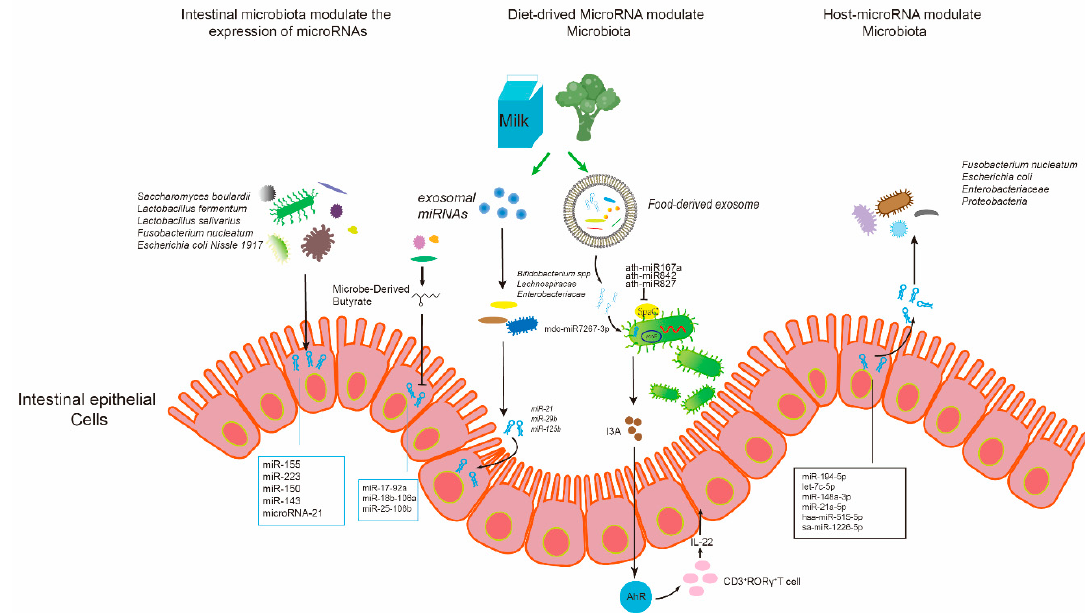
Figure 2. Summary of microRNA-microbiota interaction in gut intestine, and the crucial role in regulating intestinal homeostasis through multiple mechanisms. The microRNAs secreted by intestinal epithelial cells are released into lumen, modulating the growth of gut microbes and the composition of intestinal microbiota. Gut microbiome in the host can be influenced by diet-derived microRNAs as well, while gut intestinal microbiota may in turn regulate the expression of intestinal microRNAs in the